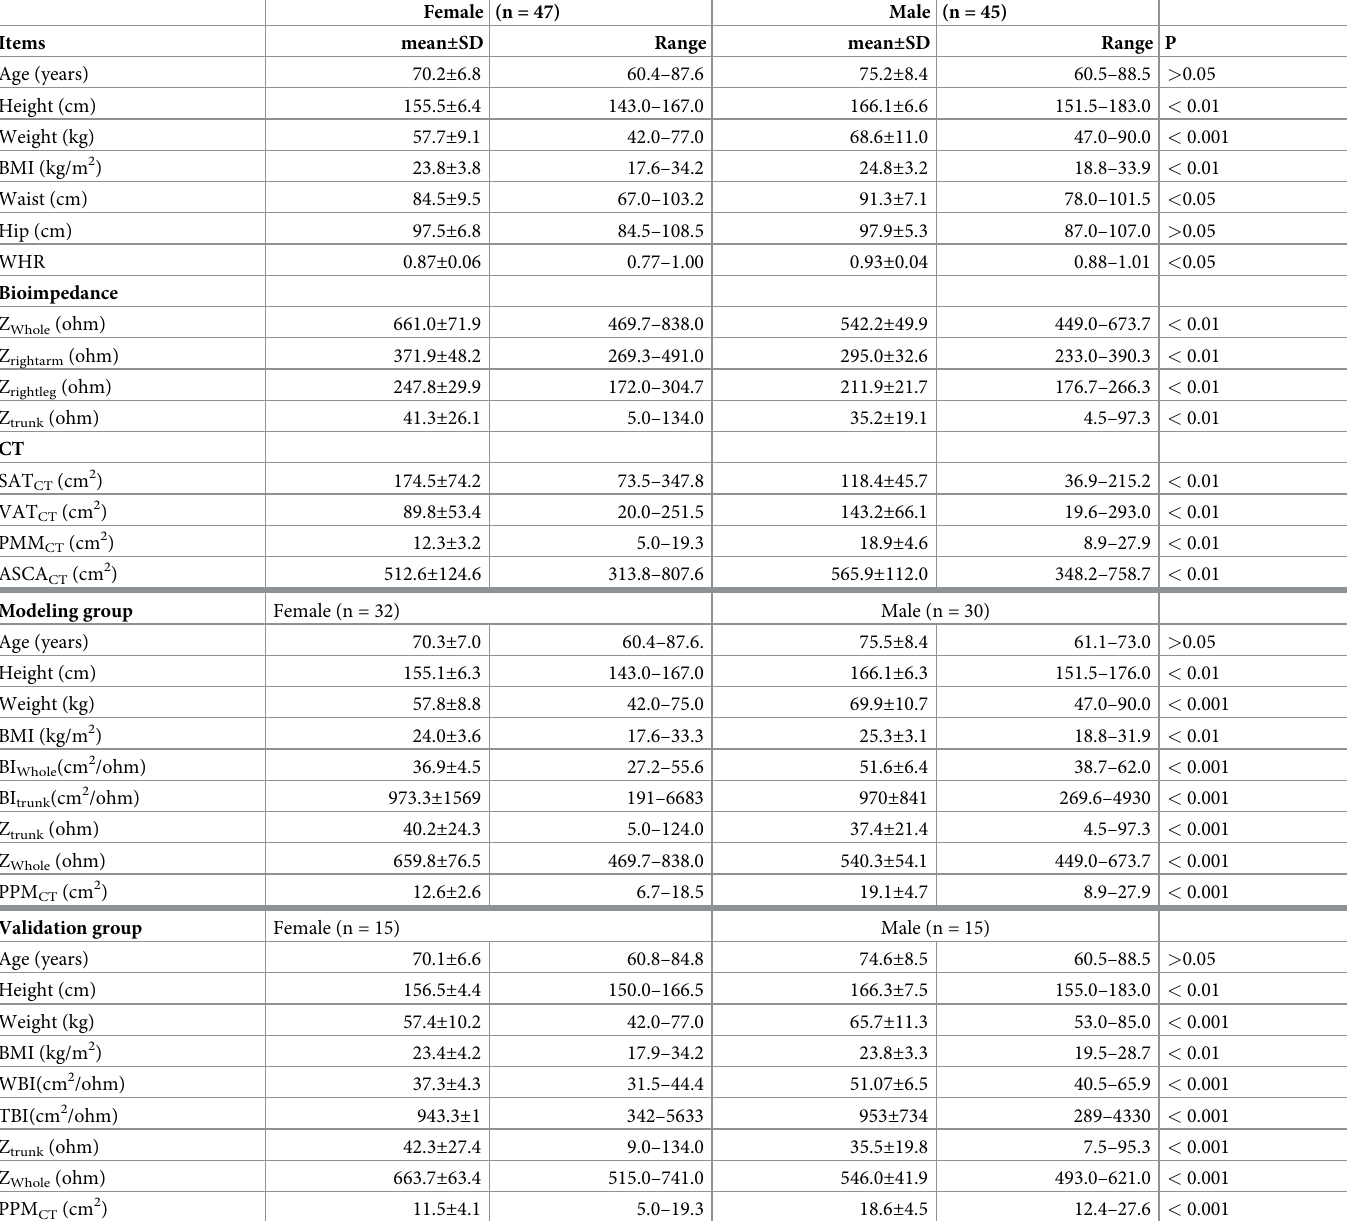
Table 1. General physical characteristics and body composition data for male and female